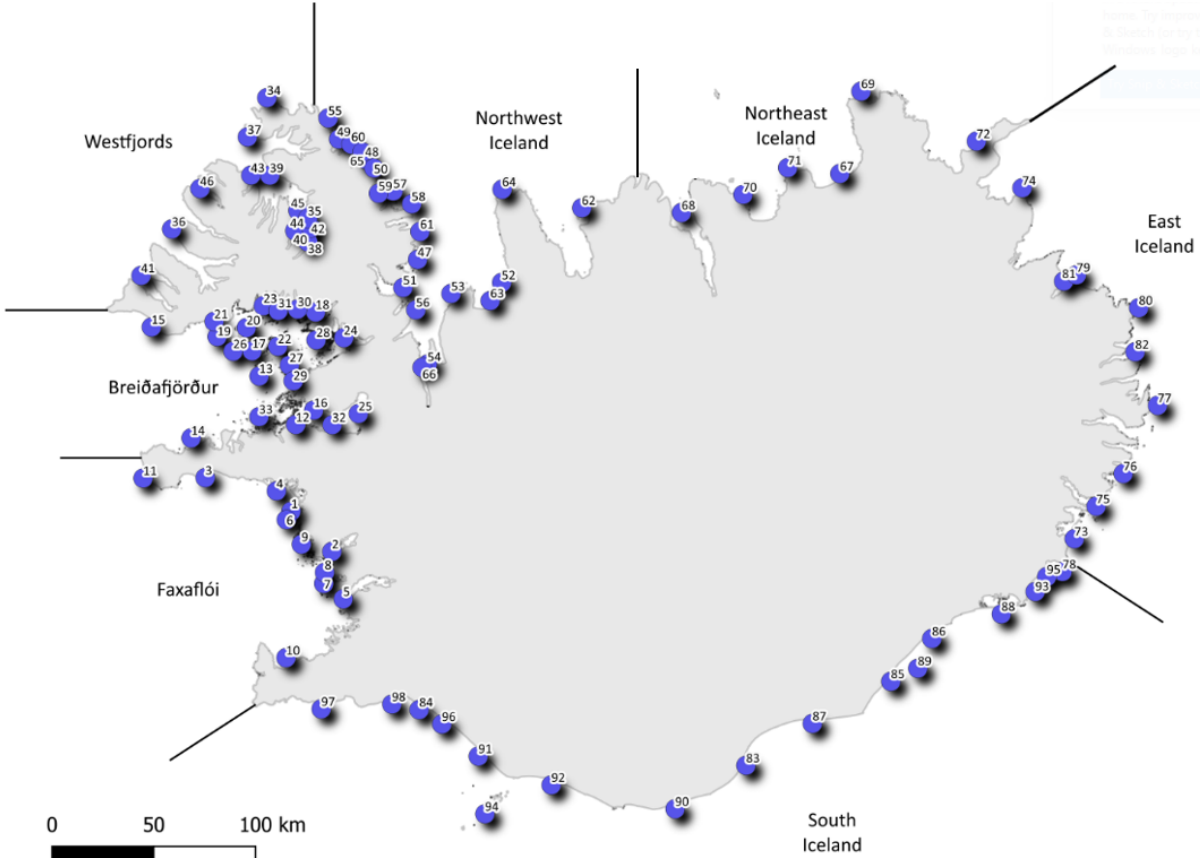
Figure 1: The seven coastal sub-areas of Iceland: Faxaflói, Breiðafjörður, Westfjords, Northwest Iceland, Northeast Iceland, East Iceland and South Iceland. The 98 counting areas are indicated by circles (the circles refer to the middle of each counting area and do not represent the exact placement of individual haul-out sites since counting areas often consist of several haul-out sites). Names and trends for the counting areas can be found in Supplementary Table